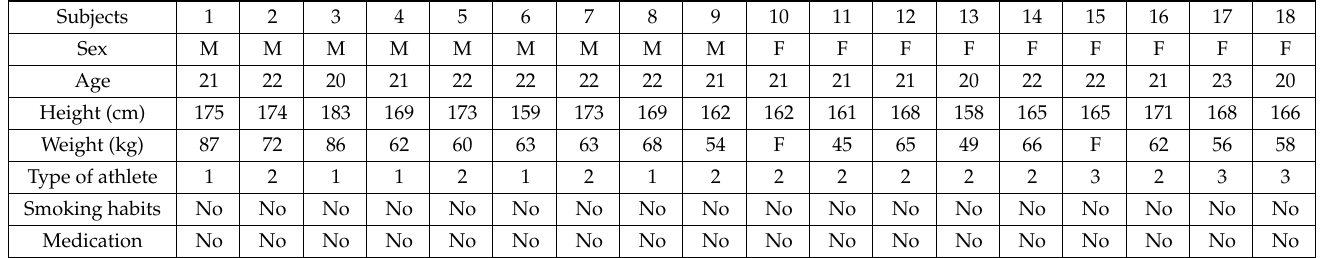
Table 1. Characteristics of the participants. The type of athlete includes (1) baseball, (2) ahletics, and (3) volleyball.